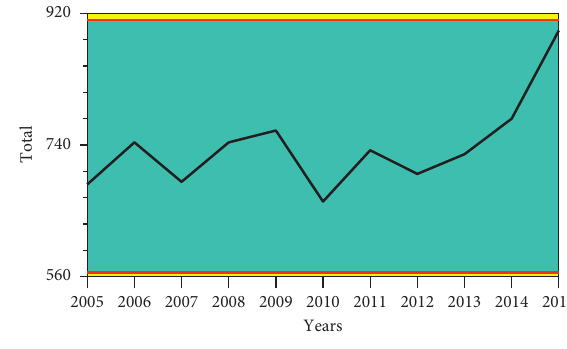
Figure 16: Limpopo: background changes.